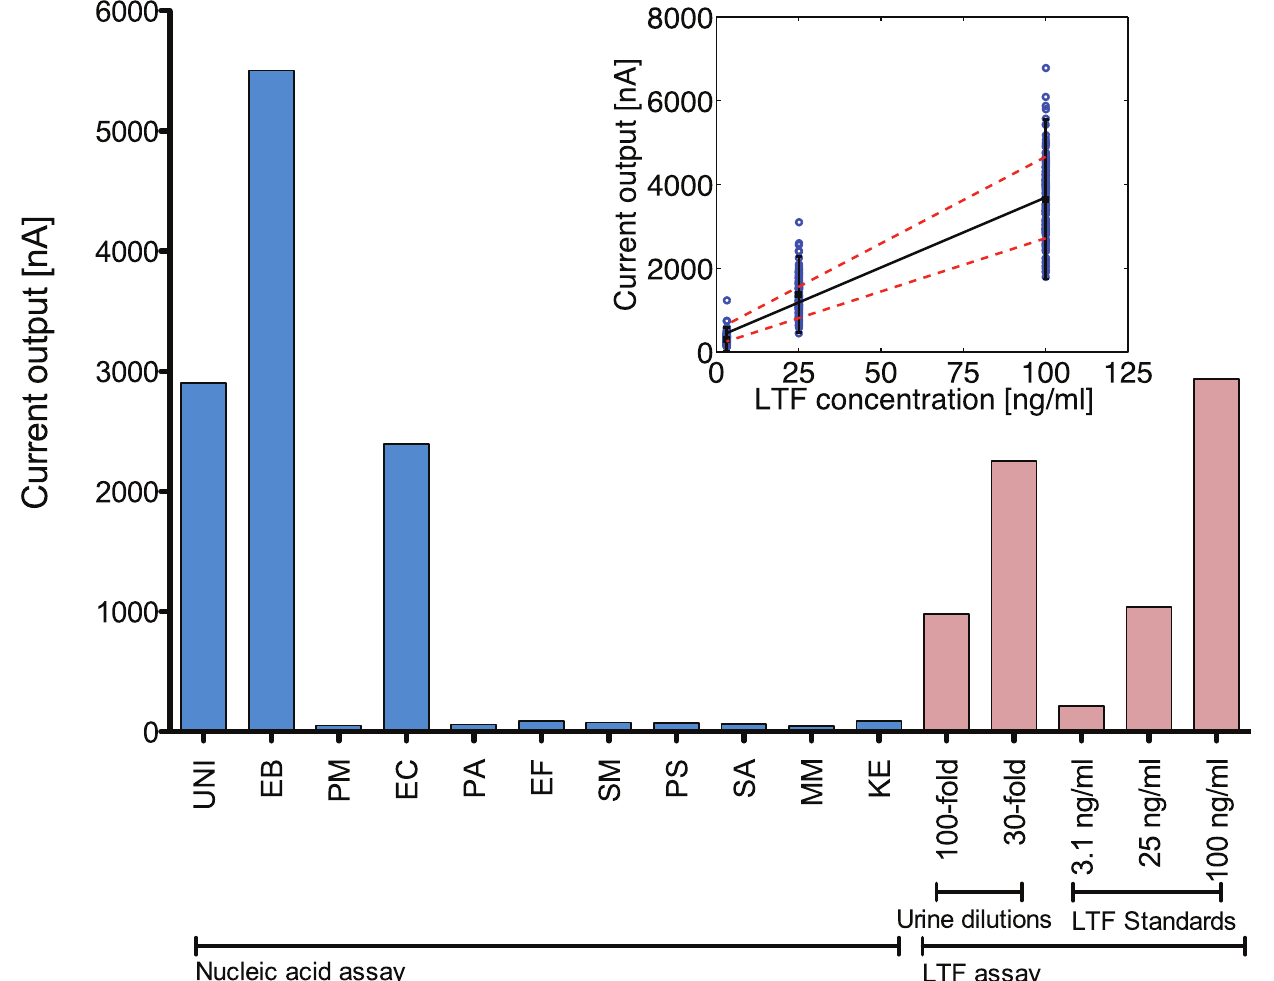
Figure 4. Example of integrated bacterial 16S rRNA and LTF biosensor assay from a urine specimen. Each array consisted of 16 electrochemical biosensors. In this study, eleven sensors were used for nucleic acid assay for pathogen identification and 5 sensors for immunoassay for LTF detection. For measurement of LTF directly from urine, two urine dilutions were tested and the concentration of LTF was determined using the standard curve generated from three known concentrations of LTF. For this urine sample, positive signals from the UNI, EB and EC probes indicated this sample contained E. coli and the measured LTF concentration of 2106 ng/ml indicated significant pyuria. This interpretation was confirmed by the clinical microbiology laboratory, which determined the sample contained . 100,000 cfu/ml E. coli and . 100 WBC/HPF. Inset shows the standard curve for detection of LTF based on 123 measurements on different biosensors on different days. The results show good reproducibility and could potentially be used for detecting the concentration of LTF from urine samples without the need of a standard curve on each